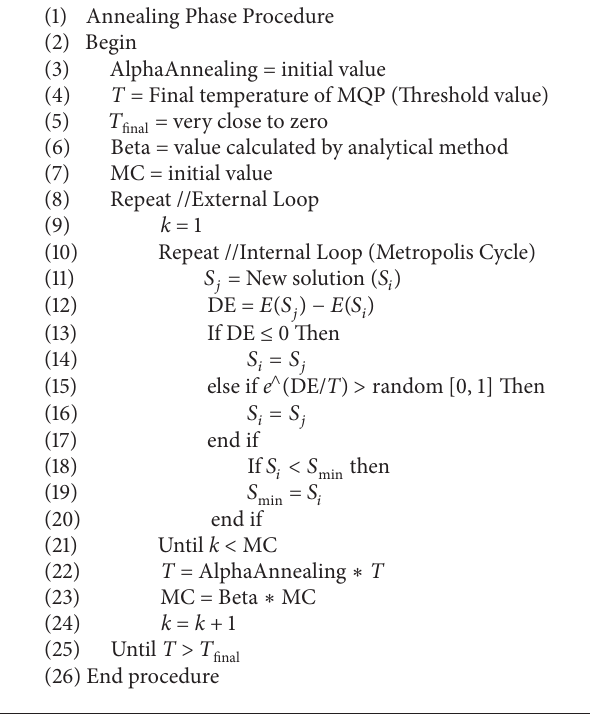
Table 1: Instances of